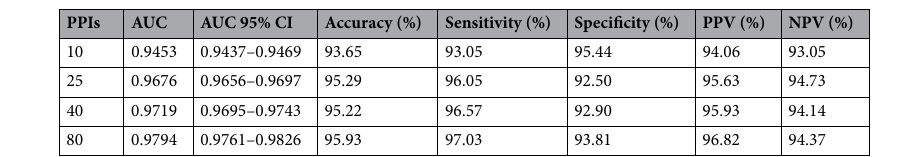
Table 4. Sensitivity, specificity, positive predictive value, negative predictive value, and accuracy among different patients between the 10-beat, 25-beat, 40-beat, and 80-beat analytic programs.